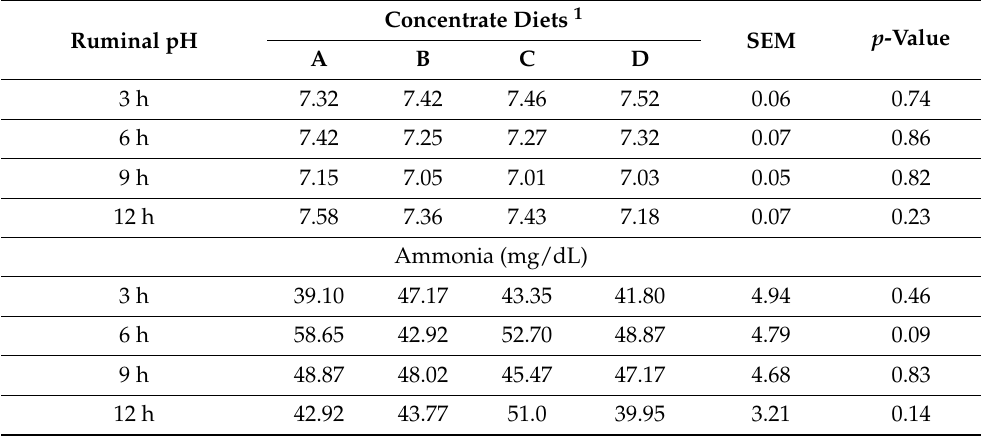
Table 5. Effect of different levels of yeast-fermented citrus pulp on ruminal pH and ammonia nitrogen in cannulated buffalo bulls.